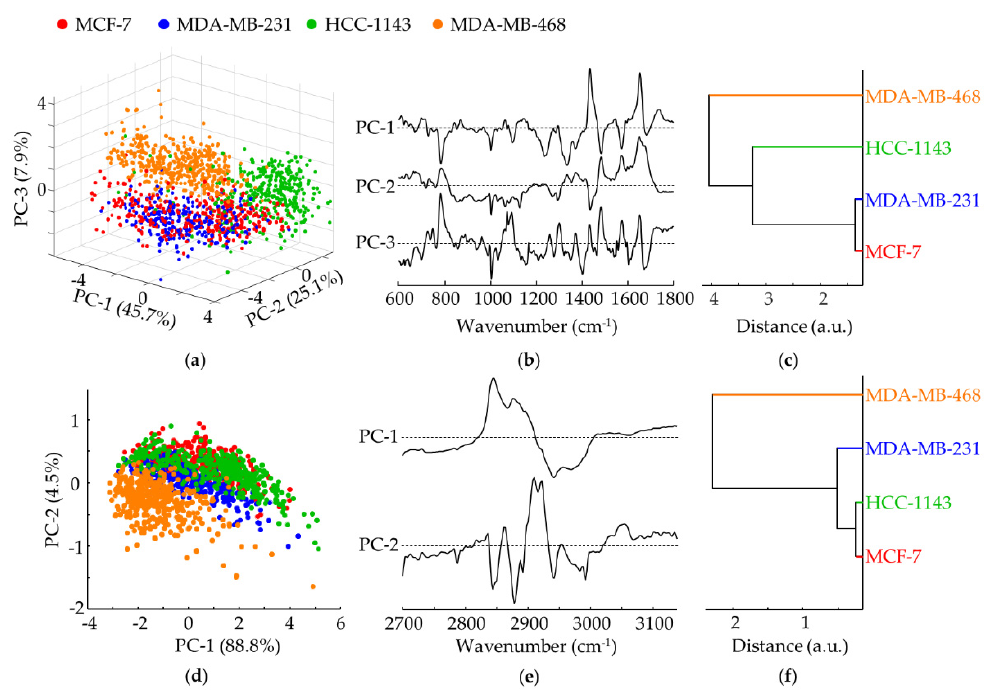
Figure 3. PCA of Raman data for all cell lines studied (MCF-7, MDA-MB-231, HCC-1143 and MDA-MB-468). ( a , b ) Scores and loading plots of the fingerprint region (600–1800 cm − 1 ). ( c ) Hierarchical clustering-derived dendrogram of the mean fingerprint Raman spectra for the four cell lines. ( d , e ) Scores and loading plots of the high wavenumber region (2700–3150 cm − 1 ). ( f ) Hierarchical clustering-derived dendrogram of the mean high-wavenumber Raman spectra for the four cell lines.